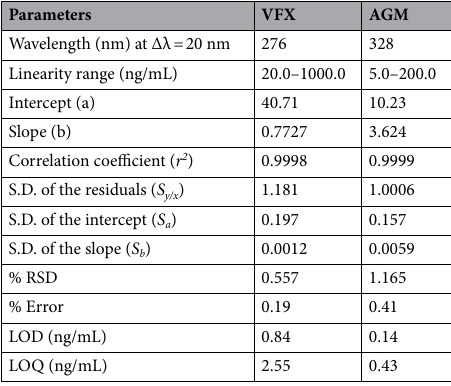
Table 1. Analytical performance data for the proposed method.